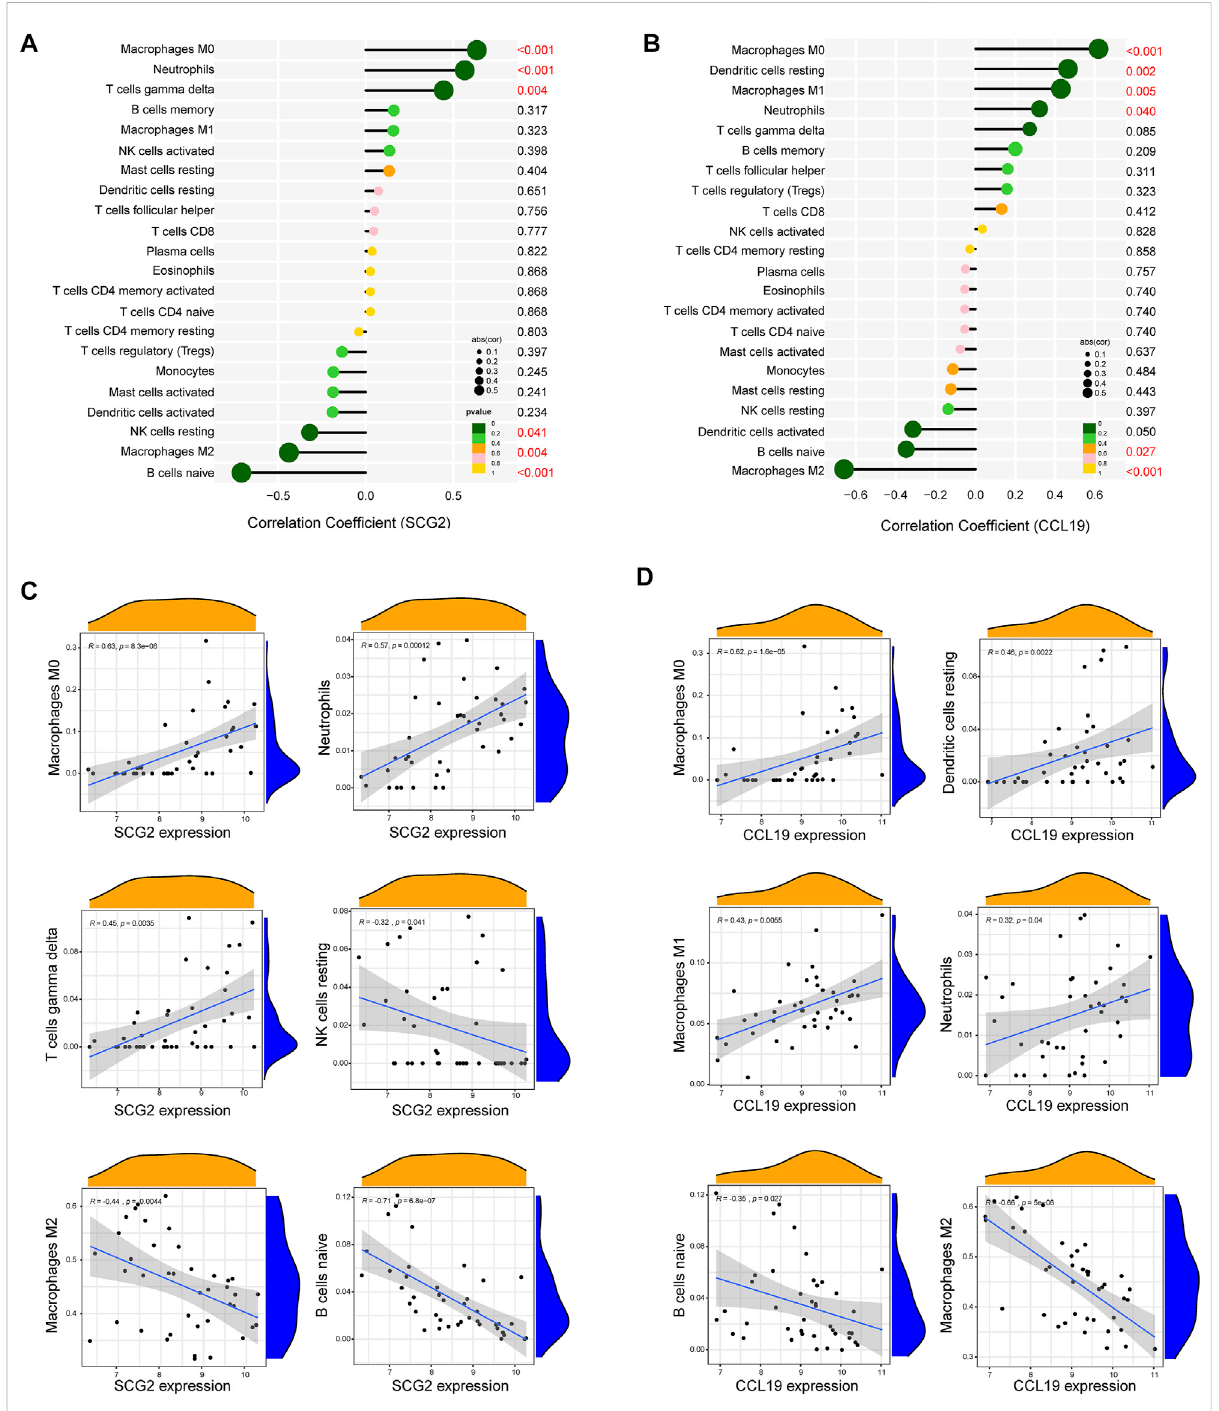
FIGURE 7 Correlation analysisbetweenkey genes and immune cells. (A) Correlation analysisfor SCG2. (B) Correlation analysisfor CCL19. Size of the dots represents the strength of the correlation between genes and immune cells, and color of the dots represents p -value. p < 0.05 was considered statistically signi fi cant. (C,D) Scatter plot showing the correlation between SCG2/CCL19 and immune cells. The X -axis represents the mRNA expression level of genes, the Y -axis represents the expression abundance of immune cells, and the R value represents the correlation coef fi